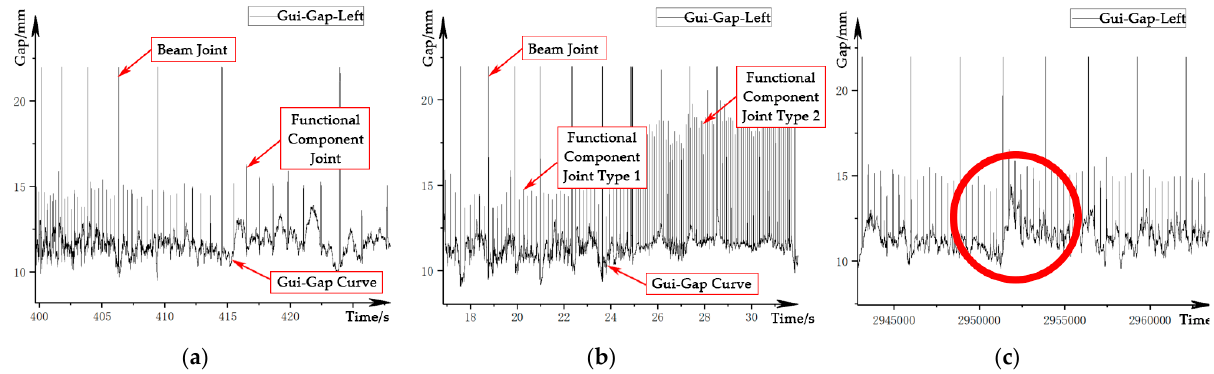
Figure 4. Waveform of the guidance gap signal: ( a ) velocity-affected signal; ( b ) structure-affected signal; ( c ) irregularity- affected signal.